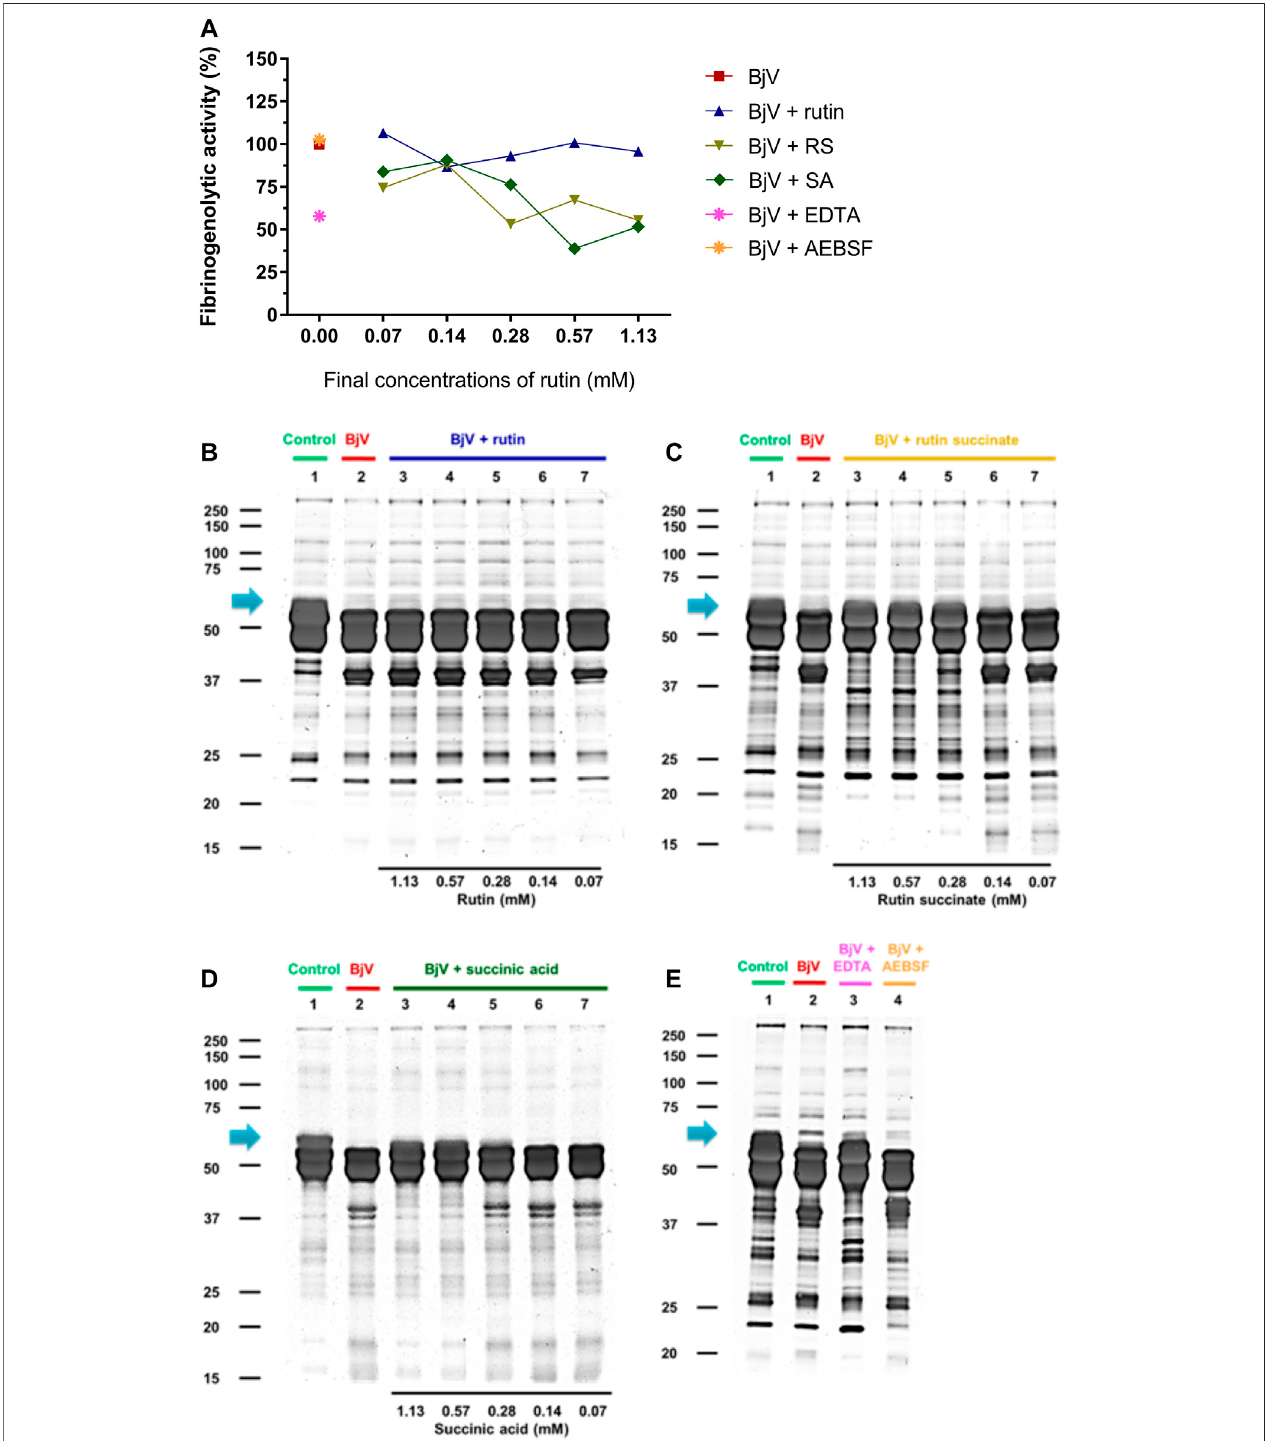
FIGURE10|(A – D) Activity ofrutin,RSandSAat differentconcentrationonBjV-induced fi brinogenolyticactivity invitro . (A) Datawereexpressed aspercentage of fi brinogenolytic activity induced by BjV alone; (B – E) fi brinogen degradation by BjV was evaluated by means of SDS-PAGE gels (10%). Fibrinogen incubated without BjV (lanes 1) or with BjV solutions at 1.0 mg/ml (lanes 2); [ (B) , BjV + rutin], lanes 3 – 7, rutin concentrations ranging from 1.13 to 0.07 mM; [ (C) , BjV + RS], lanes 3 – 7, RS concentrationsrangingfrom1.13to0.07 mM;[ (D) ,BjV+SA],lanes3 – 7,SAconcentrationsrangingfrom1.13to0.07 mM; (E) BjV+Na 2 EDTA(lane3),BjV+o-phe (lane 4) and BjV + AEBSF (lane 5). Arrows refers to interest bands of 60 kDa (approximately), relative to non-degraded fi brinogen α -chain.